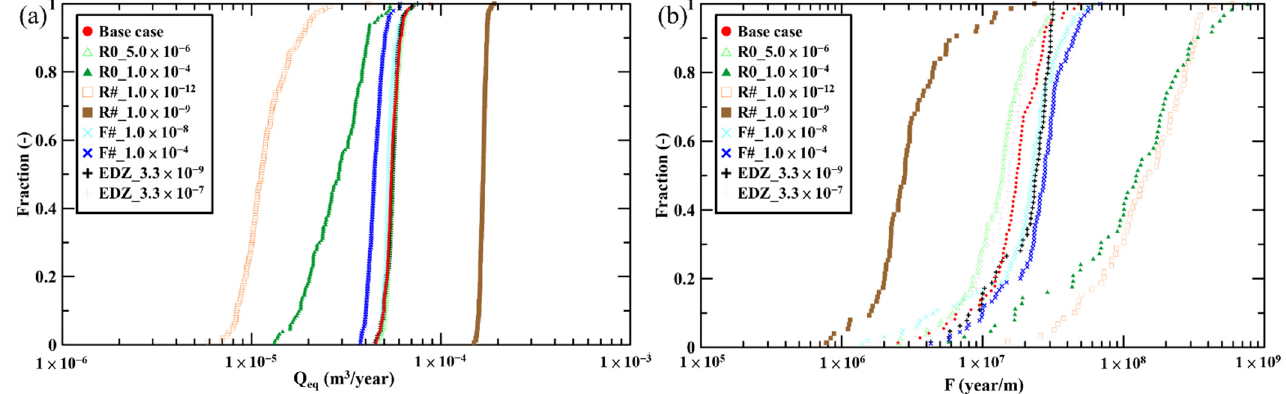
Figure 12. Q eq and F for the Q1 paths in the cases for sensitivity analyses. ( a ) The Q eq for the Q1 path of the sensitivity study cases. ( b ) The F for the Q1 path of sensitivity study cases. Table 4. The maximum and minimum values of Q eq and F for the base case and the sensitivity analysis cases.